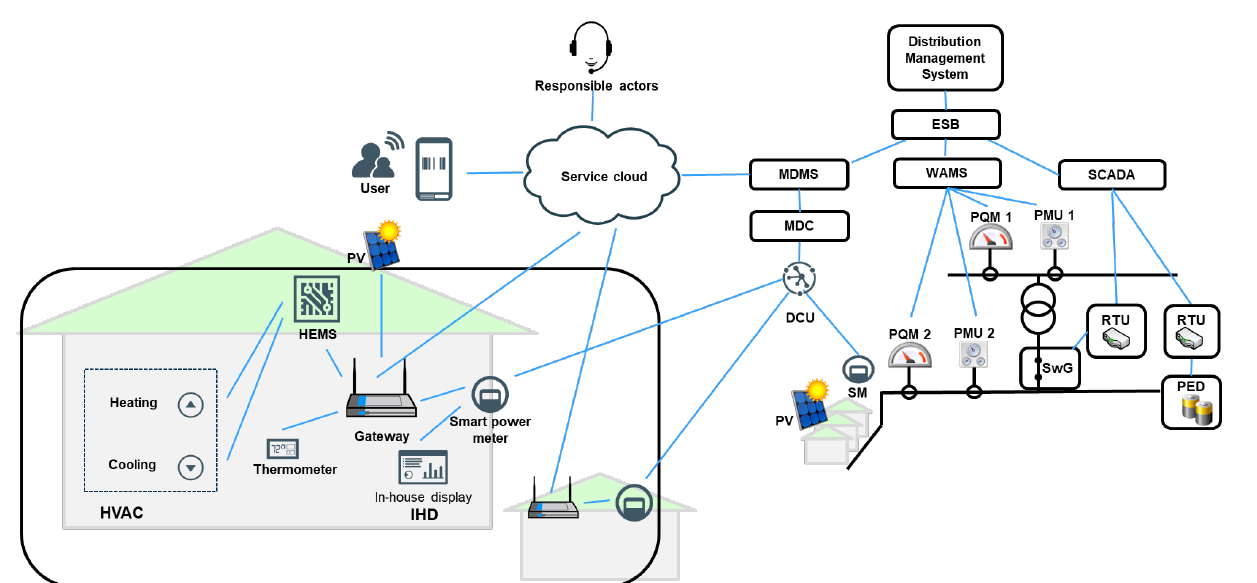
Figure 2. Smart energy system cyber security use case